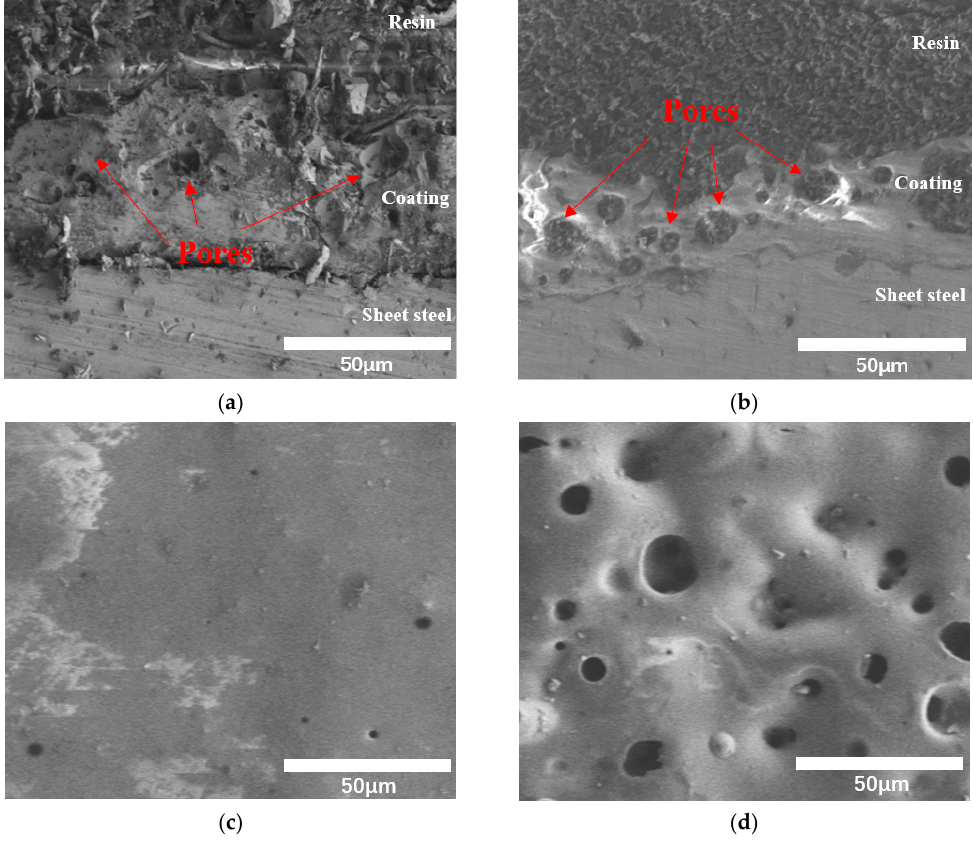
Figure 9. Cross-section morphology and surface morphology of Samples 4 and 5 taken by SEM: ( a ) cross-section morphology of Sample 4; ( b ) cross-section morphology of Sample 5; ( c ) surface morphology of Sample 4; and ( d ) surface morphology of Sample 5.